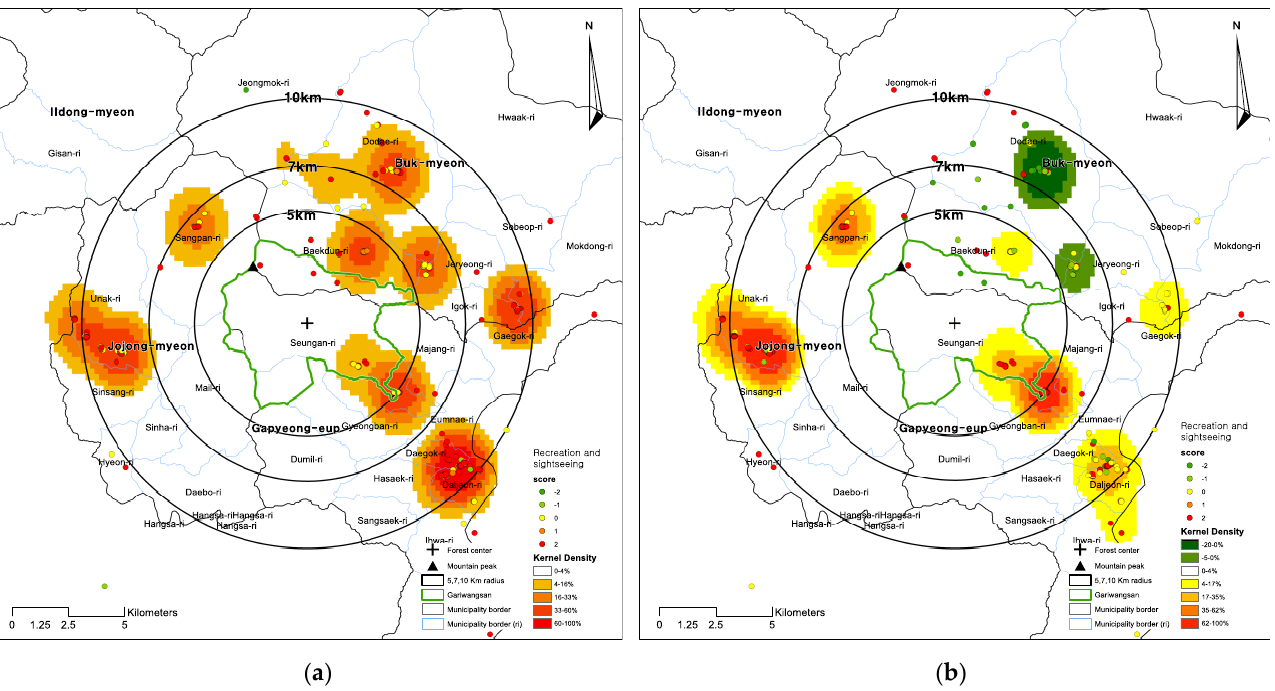
Figure 9. Kernel density maps of ( a ) recreation and sightseeing and ( b ) air quality improvements in Gariwangsan.